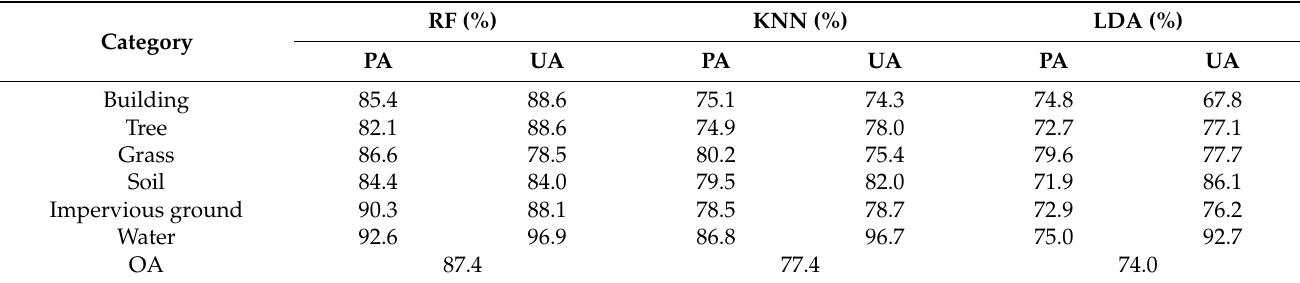
Table 6. Comparisons of the performances of RF, KNN, and LDA algorithms in land cover mapping. OA, PA, and UA represent overall accuracy, producer’s accuracy, and user’s accuracy, respectively. Category Building Tree Grass Soil Impervious ground Water